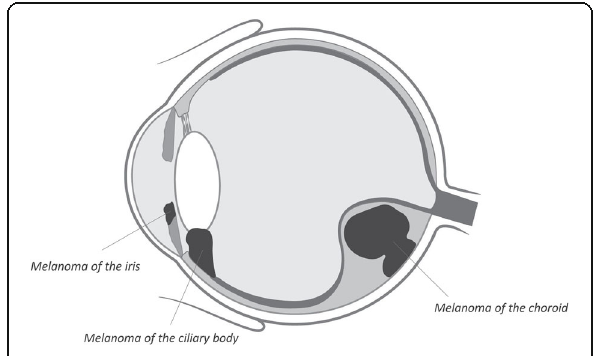
Fig. 2 Anatomy of uveal melanoma. (Modified from the figure